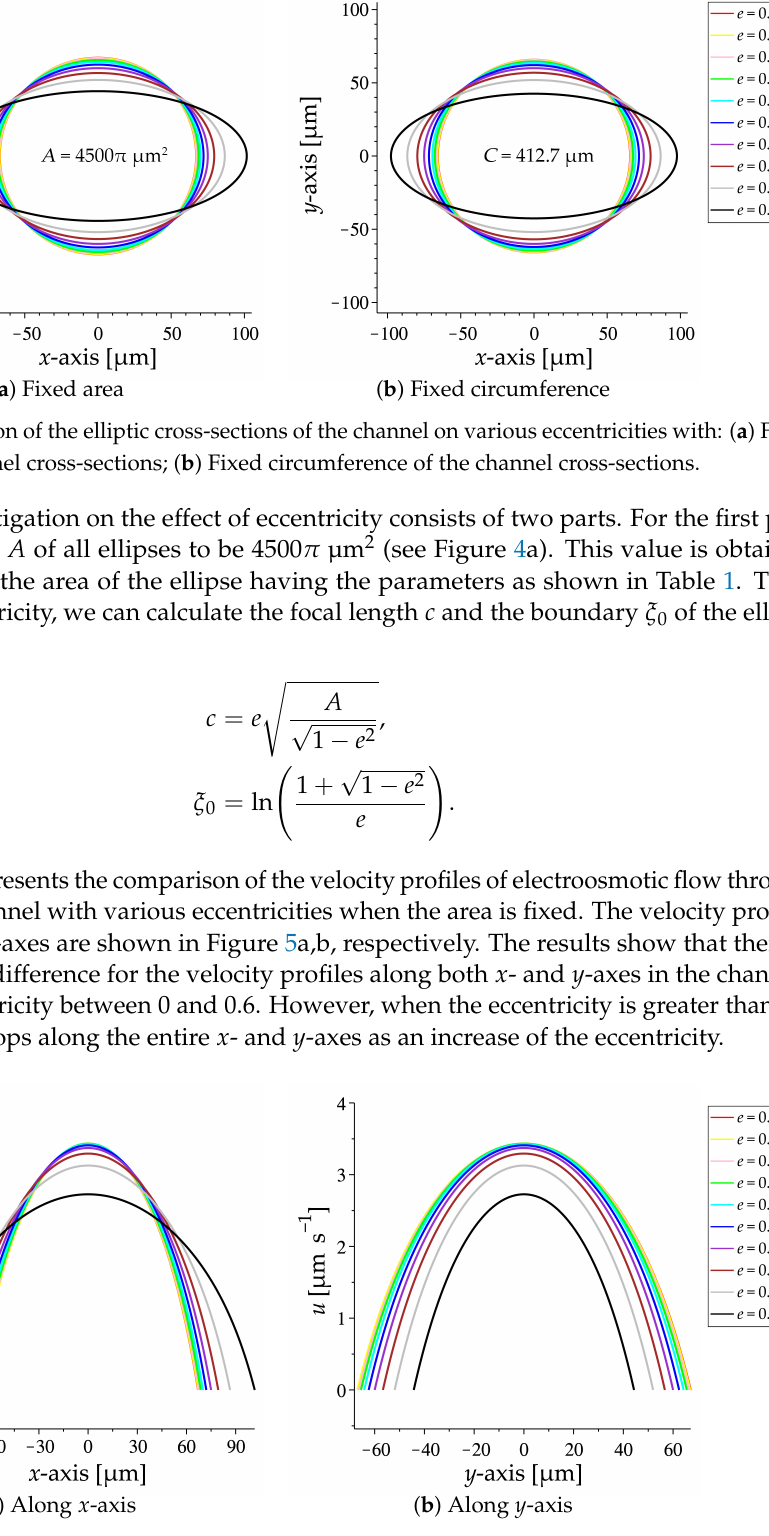
Figure 5. Variation of the velocity profiles of steady electroosmotic flow, when the area of the channel cross-sections is fixed, with various eccentricities: ( a ) Along x -axis; ( b ) Along y